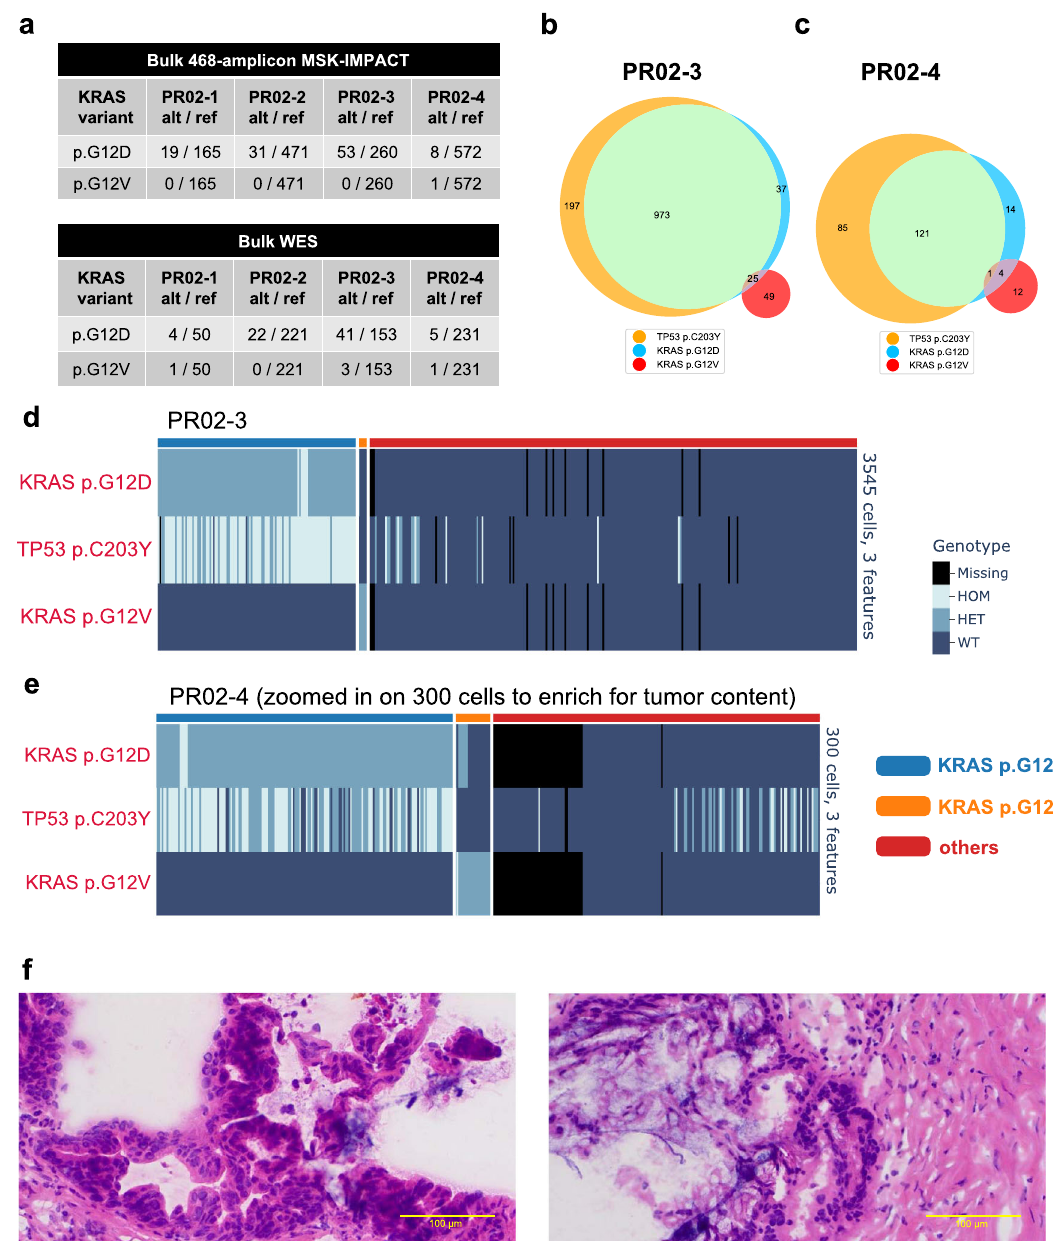
Fig. 4 | SnDNA-seq identi fi ed two mutually exclusive clones bearing two dif- ferentKRASmutationsinonepancreaticcancerpatient.a Bulk-sequencingcalls of KRAS variants of patient PR02 ’ s 4 multiregional primary tumor samples. Venn diagram showing colocalization pattern of genetic variants TP53 p.C203Y, KRAS p.G12D, KRAS p.G12VinsinglenucleusofsamplesPR02-3( b ),PR02-4( c